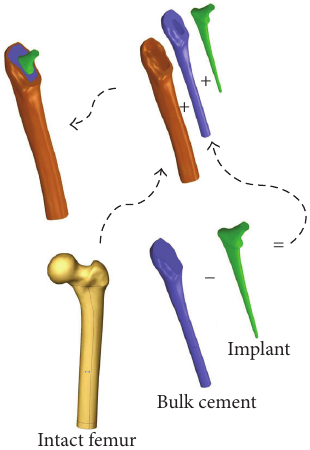
Figure 1: The intact femur bone was cut at its proximal part to allow for insertion of the implant. The geometry of the implant was deducted from the bulk cement represented and fixed length of the void inside the cortical bone. The implant and updated cement geometry were then aligned with the axis of the cortical bone and a femur-cement-implant construct was